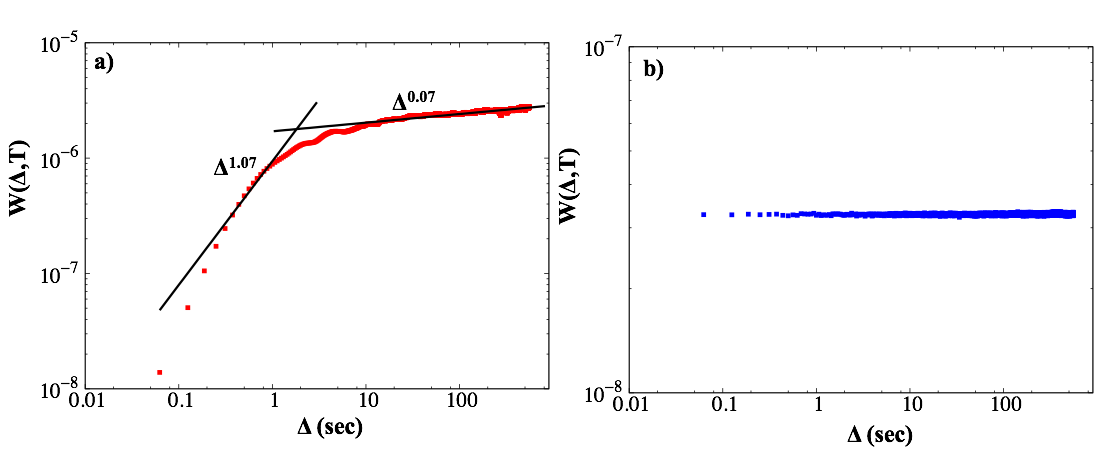
Figure 3. The logarithmic plots of variance estimated by using Equation (2) versus the lag time for ( a ) temperature and ( b )